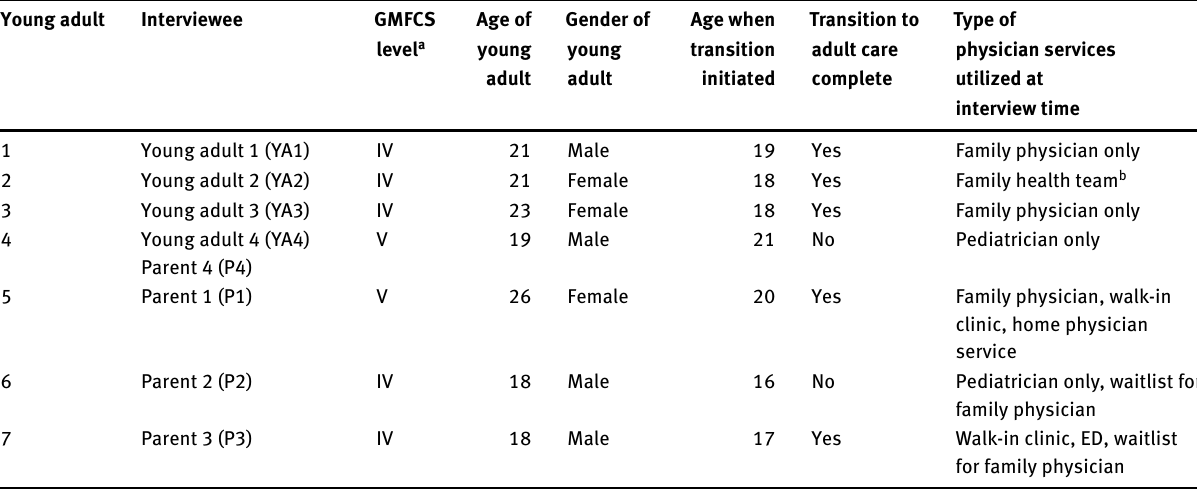
Table 1: Characteristics of young adults with cerebral